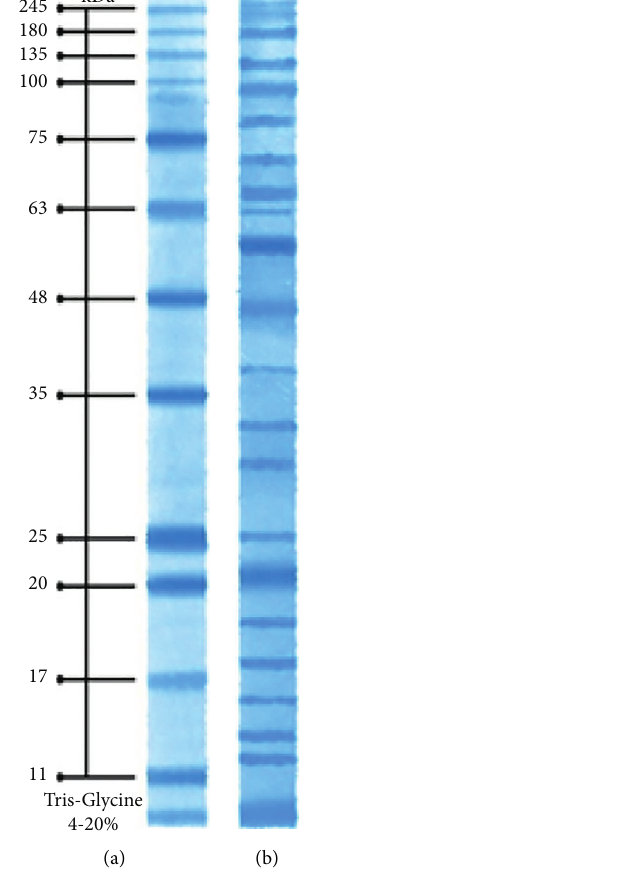
Figure 1: SDS-PAGE: (a) sinaclon marker (Tris-Glycine) and (b) tunichrome released from Phallusia nigra Persian Gulf marine tunicate.